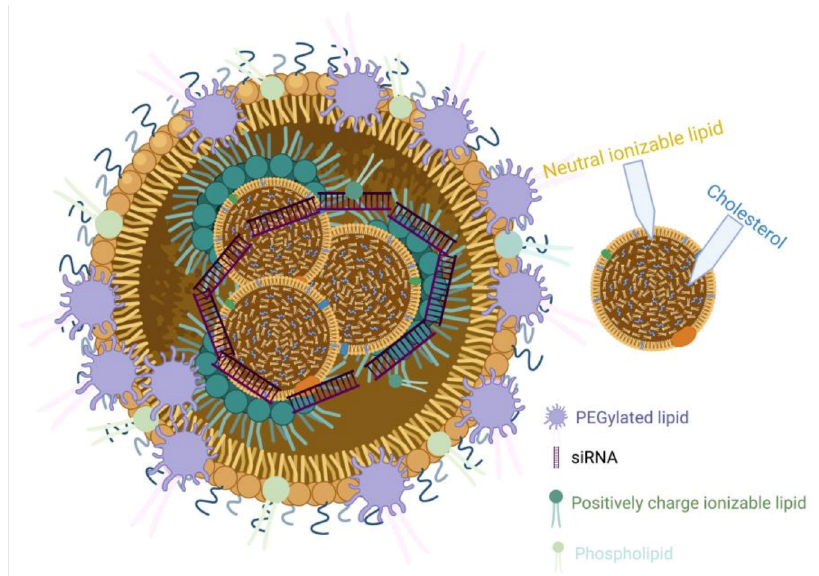
Figure 1. Schematic illustration of LNPs containing siRNA and other key lipid components.